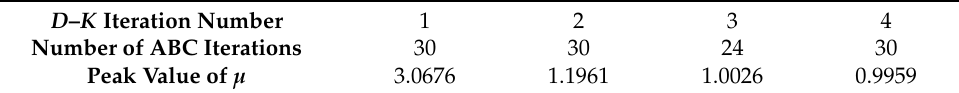
Table 3. The evolution of the structural singular value in the D – K iteration procedure used to solve the mixed-sensitivity fixed structure µ -synthesis problem for the case study—FO-PI structure.